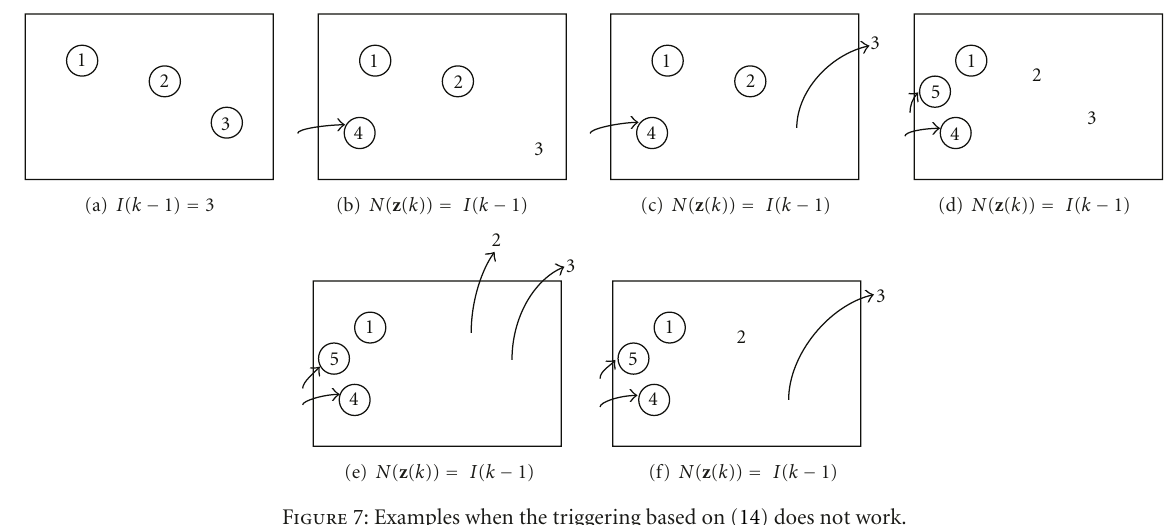
Figure 7: Examples when the triggering based on (14) does not work.